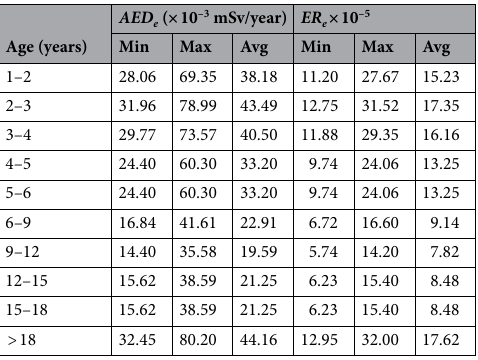
Table 8. Age-dependent annual effective dose ( AED e ) and excess risk ER e induced by the exposure of ambient environment for the population around Qinshan NPP from 2012 to 2020.